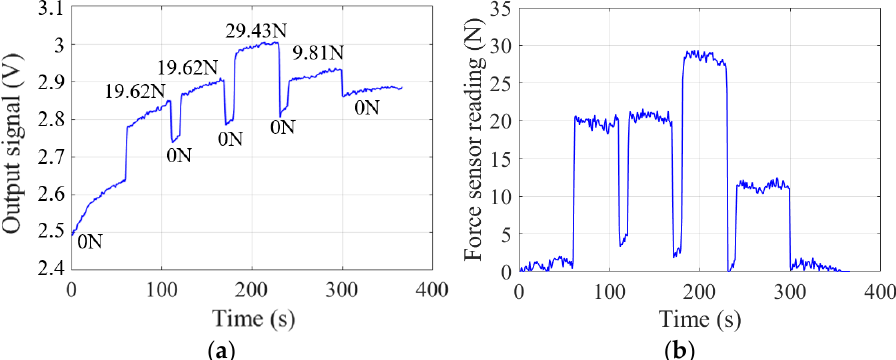
Figure 14. The external validation of the ANN model: ( a ) the raw data of the external validation set; and ( b ) the force sensor reading of the smart tool holder with ANN calibration.